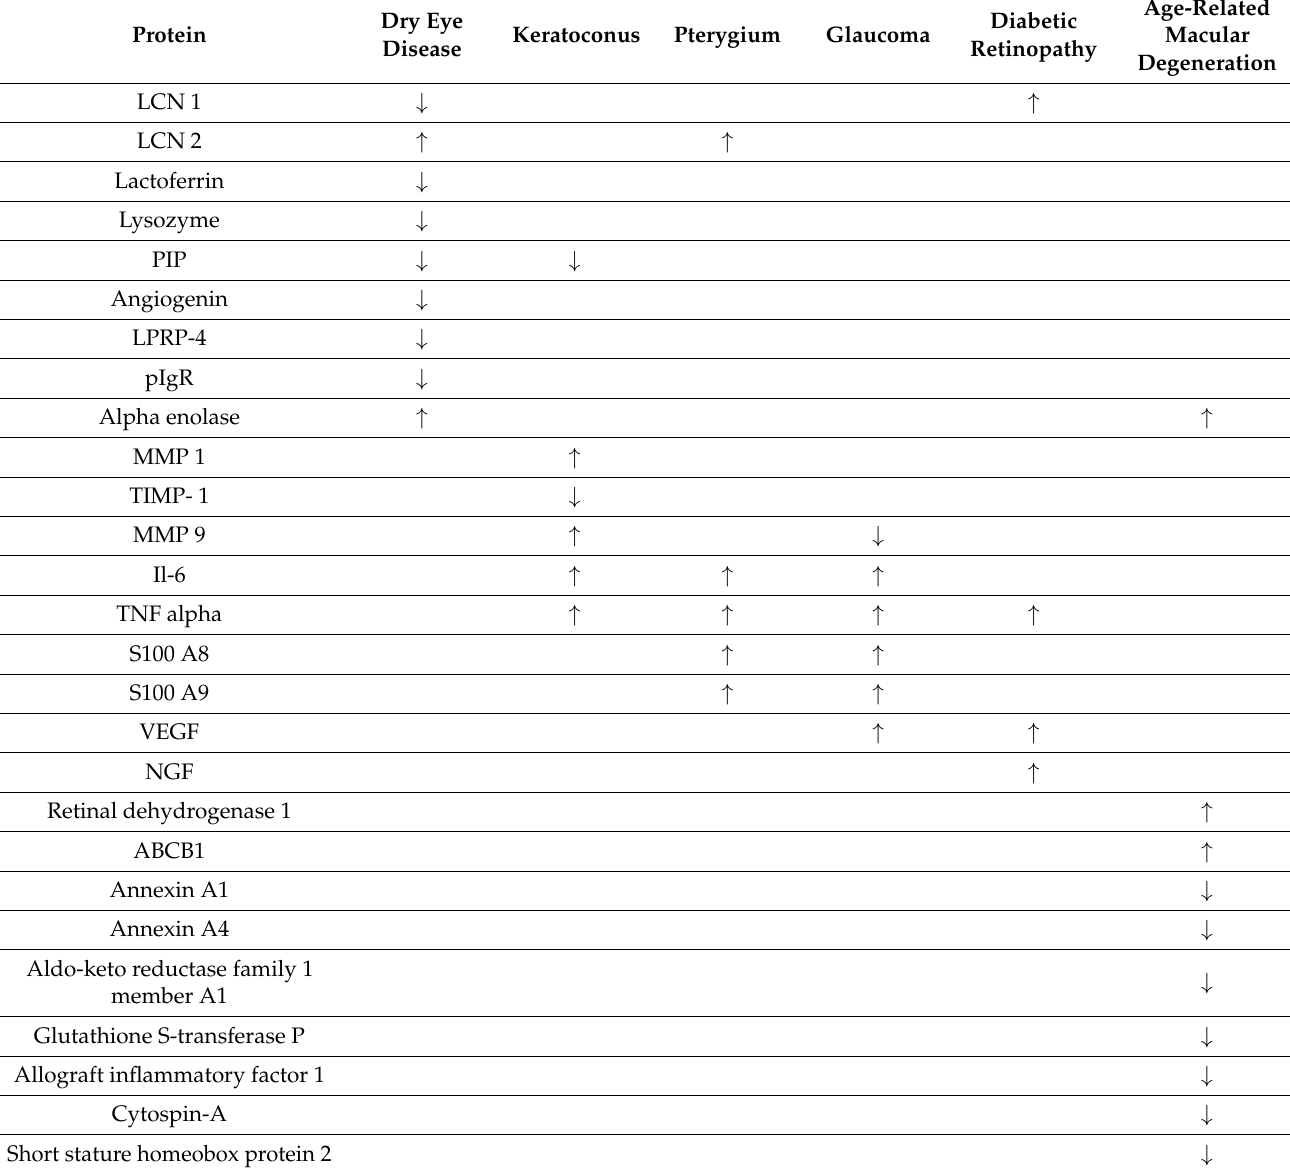
Table 2. Proteomic alterations in tear film of various ocular diseases.